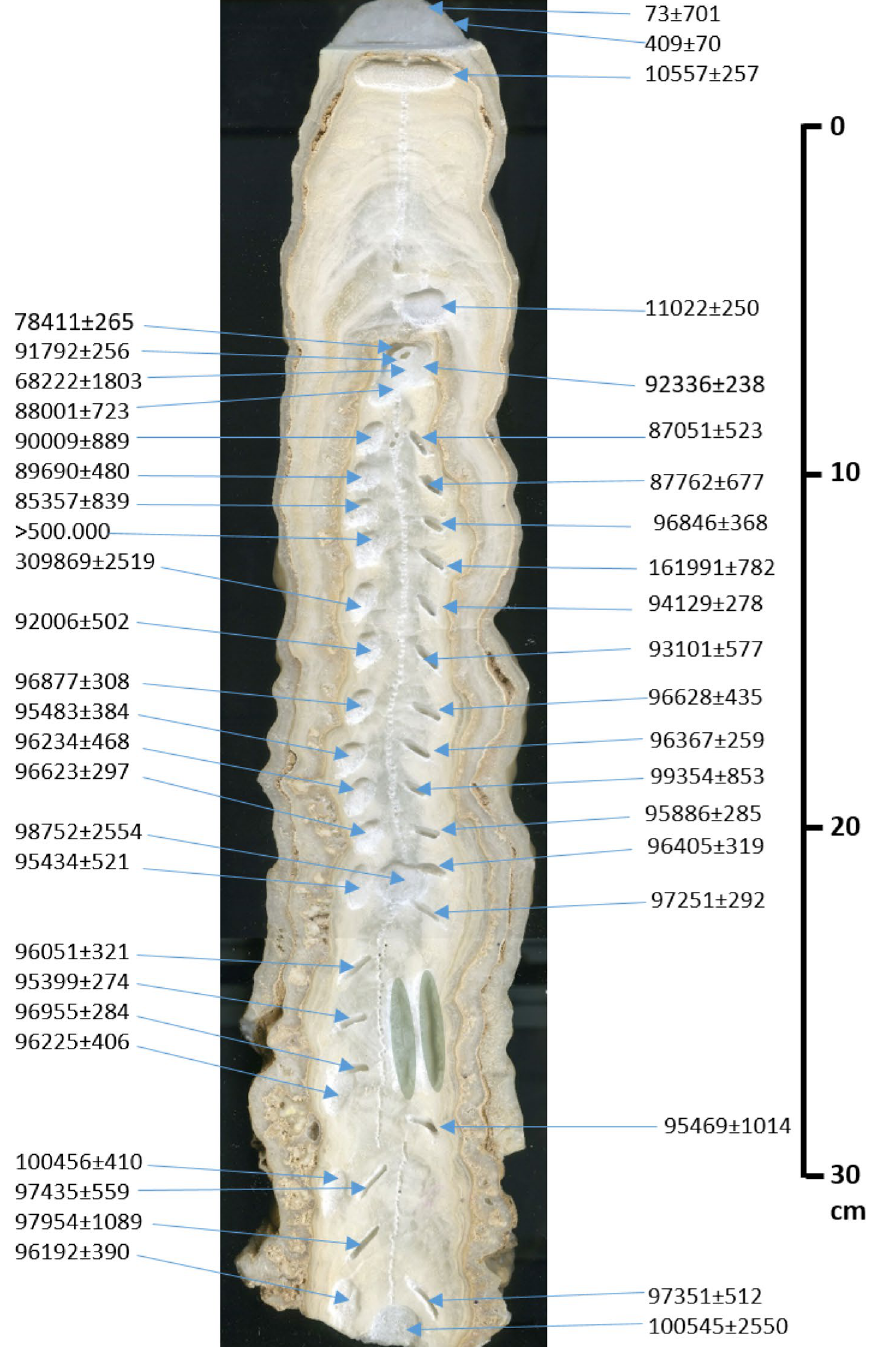
Figure 2. Stalagmite MCS-01 indicating the location of U–Th dating samples, with ages reported in B.P., and the approximate sample positions for the X-Ray Diffraction (green